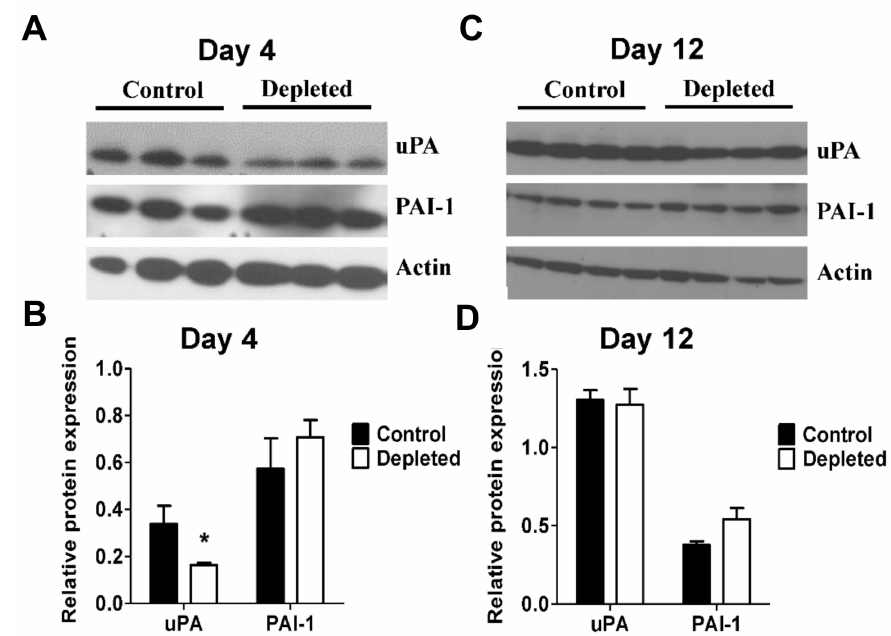
Figure 5. T cell depleted thrombi has reduced fibrinolytic activity. ( A ) and ( C ) Immunoblot analysis of intra-thrombotic fibrinolytic markers uPA and PAI-1 at days 4 and 12 after vena cava ligation in venous thrombus samples from control and T cell depleted mice (Day 4 n = 3, Day 12 n = 4). ( B ) and ( D ) Quantitative analysis of the expression of uPA and PAI-1. All values represent the mean ± SEM. * p < 0.05, control versus T cell